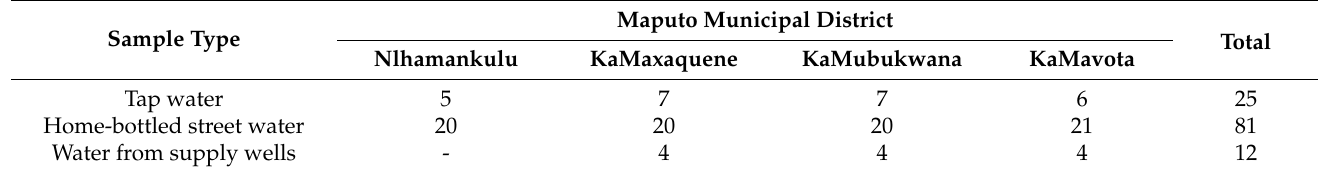
Table 1. Number and type of water samples collected in Maputo municipal districts. Sample